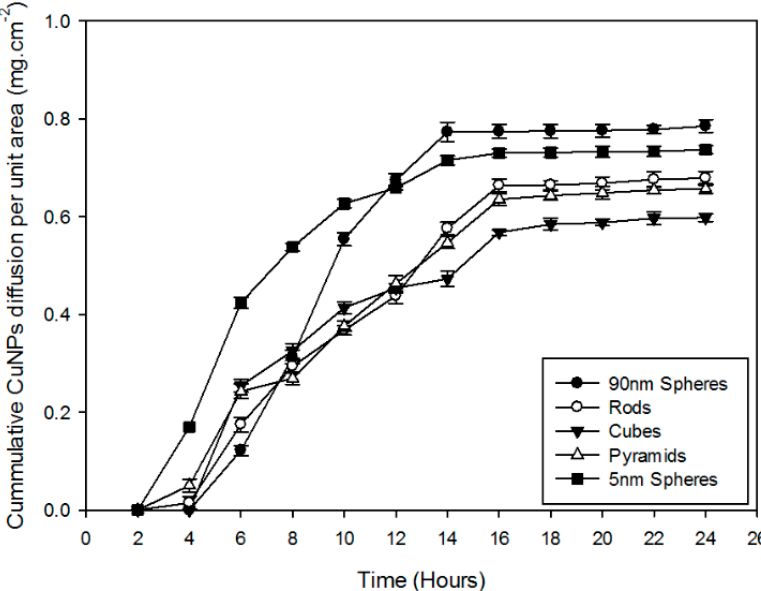
Figure 5. Ex vivo permeation profiles of geometric copper nanoparticles through excised BALB/c mice dermal tissue ( n = 3). Table 3. Copper nanoparticle flux and associated permeability coefficients for the geometric copper nanoparticles through excised BALB/c mice dermal tissue ( n = 3).